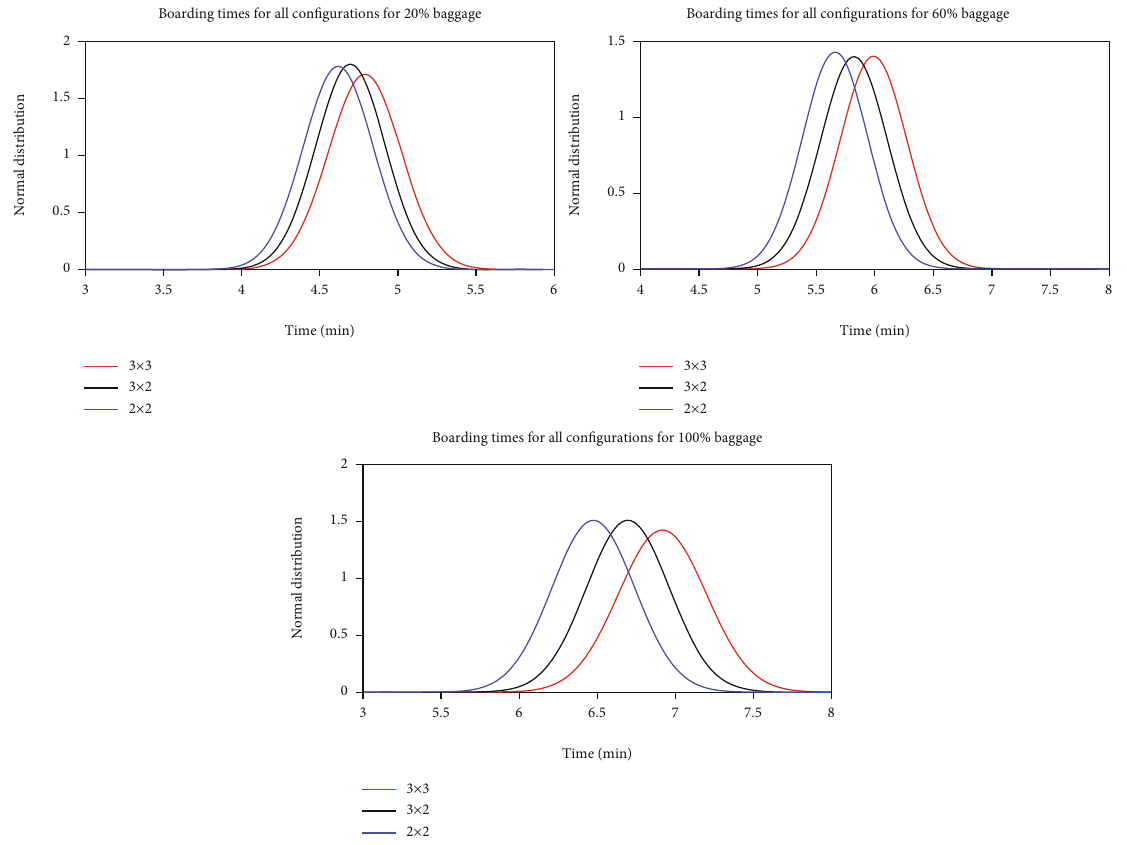
Figure 14: Fitted normal distribution curves for each aircraft con fi guration using the random outside-in boarding strategy for di ff erent % of